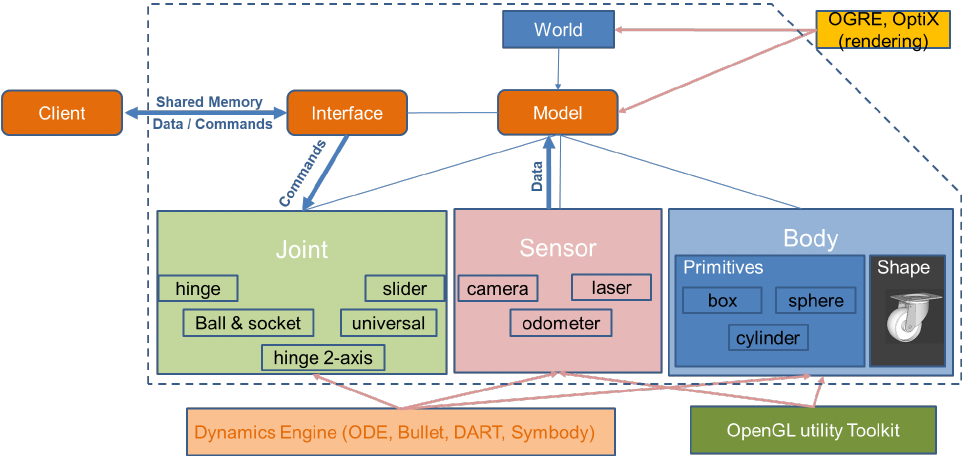
Figure 1. Gazebo General Structure. Source: Adapted from Koenig et Howard (2004 p.2150). Figure 1. Gazebo general